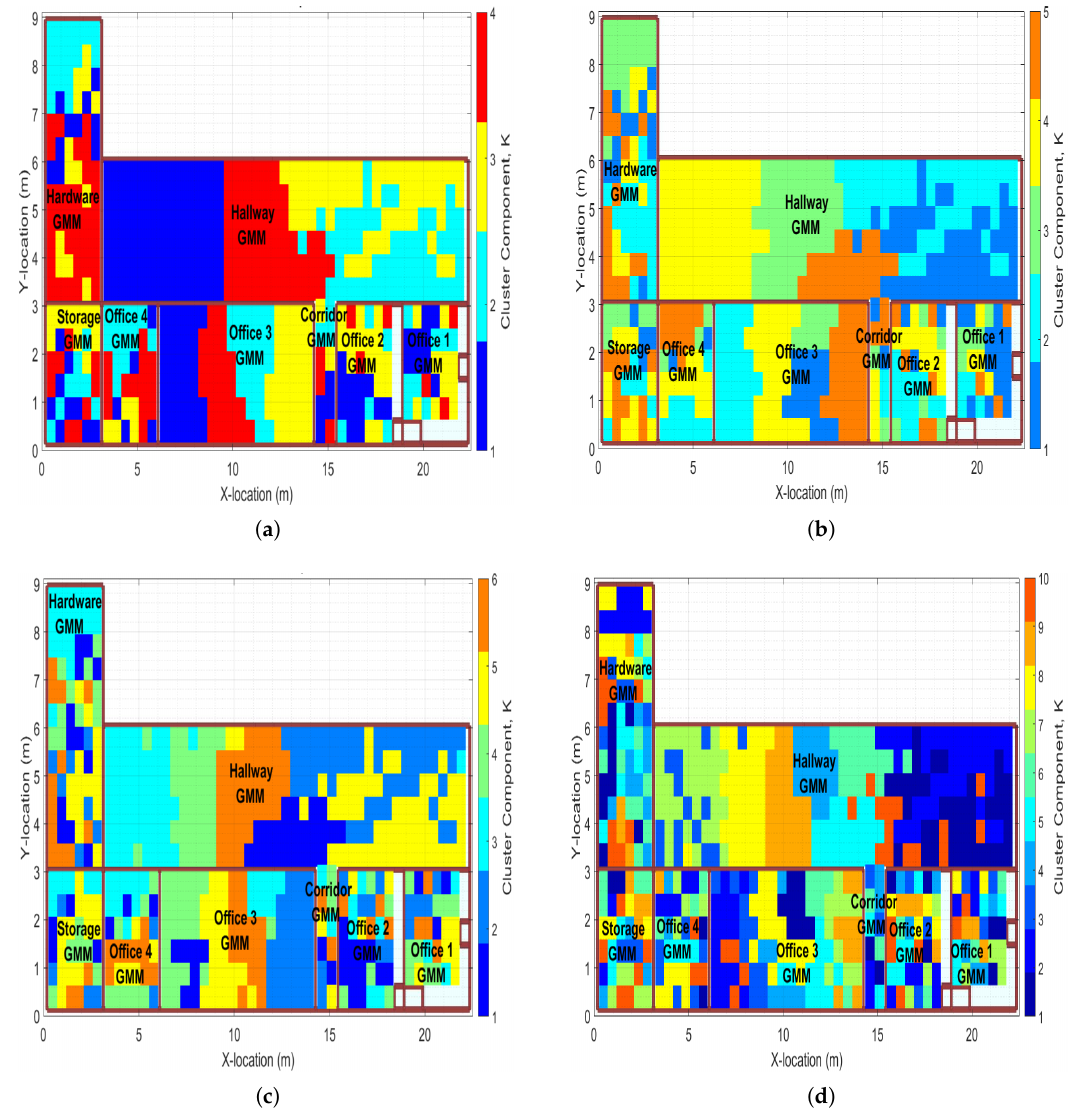
Figure 8. GMM results for region of interest (RoI) localization of non-cooperative emitters with respect to various K clustering components. ( a ) RoI with four clusters, ( b ) RoI with five clusters, ( c ) RoI with six clusters, ( d ) RoI with 10